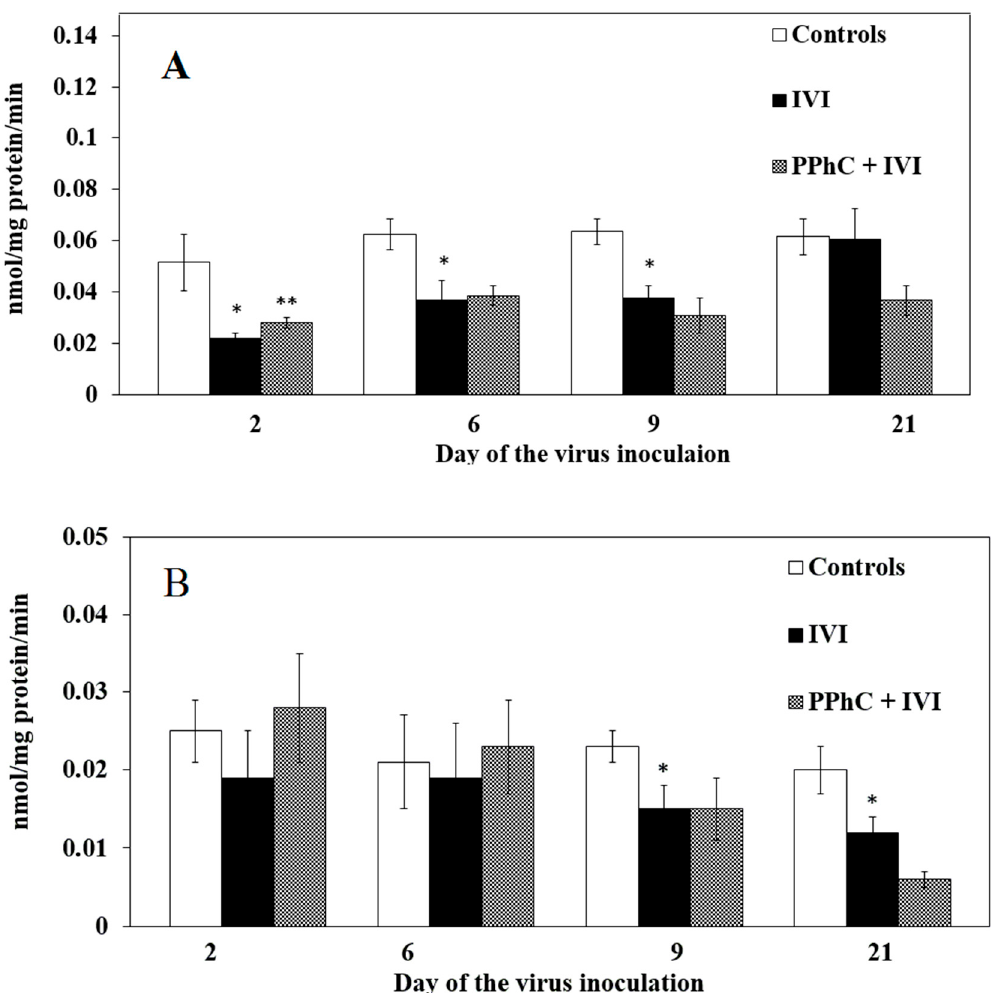
Figure 3. Panel of liver cytochrome P450 (CYP450) ( A ) content and NADPH-cytochrome P450 reductase activity with substrate cytochrome C (CCR) ( B ) activity characterizing the effect of PPhC in IVI-infected mice. Statistical significance ( p < 0.05) between the mean healthy groups enzymatic activities vs. IVI models is indicated via the asterisk (*) and between the mean IVI group’s enzymatic activities vs. those treated with the PPhC IVI groups is indicated via a double asterisk (**).